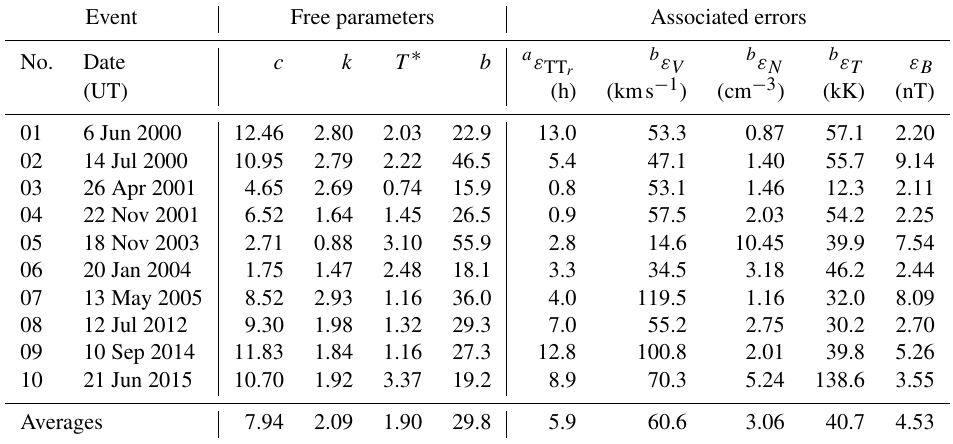
Table 2. Results from our analysis. From the left to the right: event number, CME detection date and time, values of free parameters, and associated errors with our calculated results.